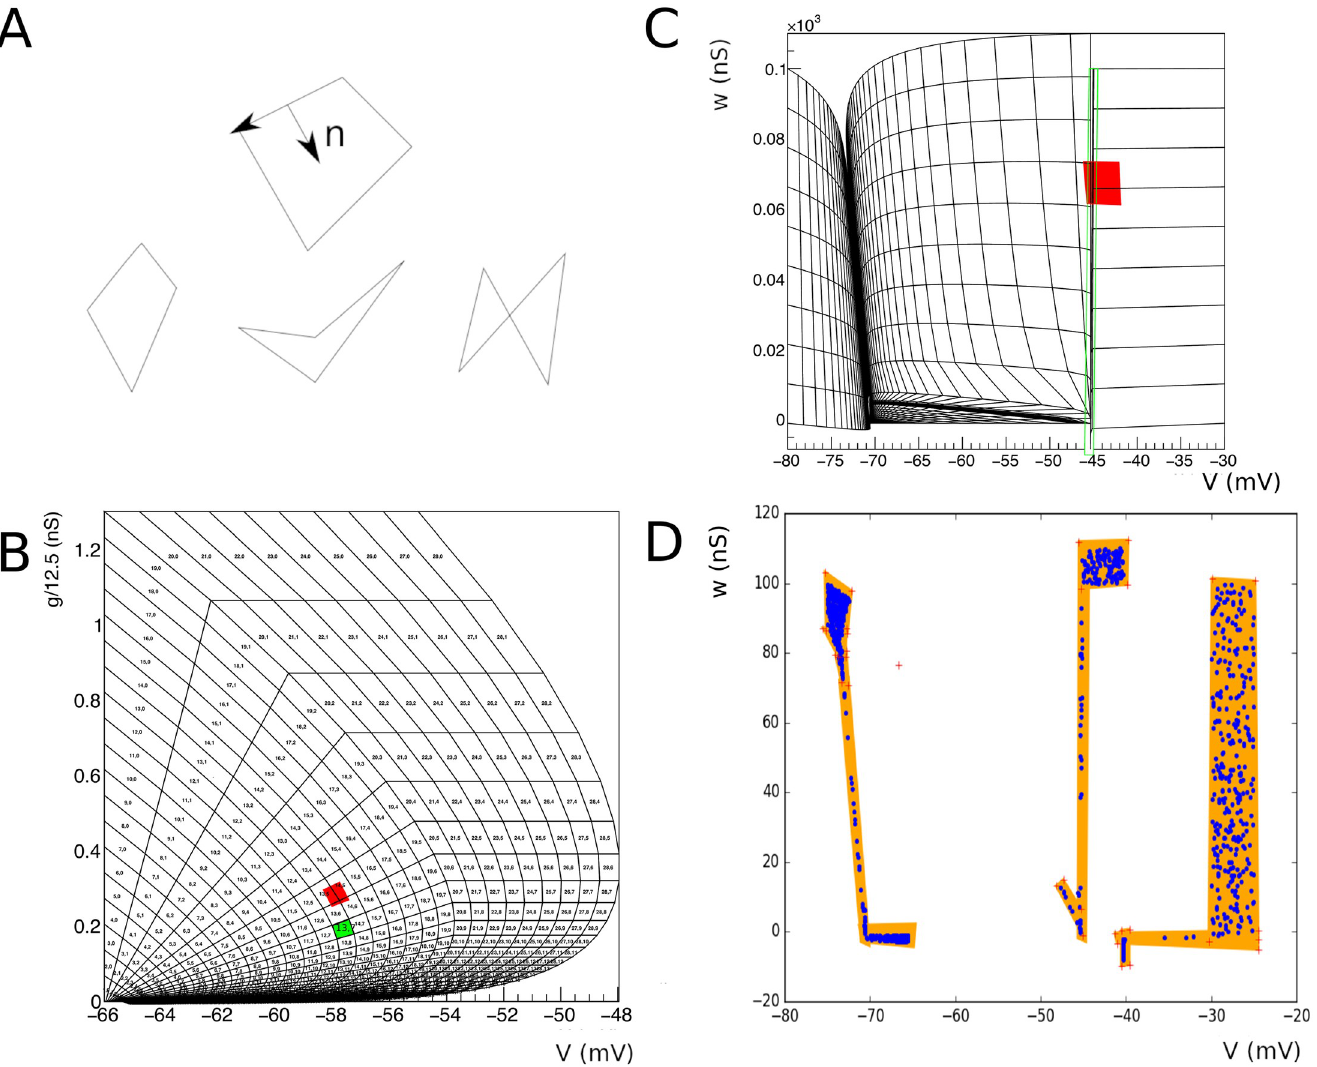
Fig 2. A: As a result of the integration procedure simple quadrilaterals (left, middle) should emerge, which are usually convex (left), except near stationary points or limit cycles where concave quadrilaterals (middle) can be formed. Complex, i.e. self-intersecting, quadrilaterals can occur around strong non linearities, for example the crossing of nullclines. These definitions hold for any polygon. B: The problem of defining the Master equation: we can easily calculate how much mass per unit time leaves a given bin ( i , j ). This mass will reappear at a position h away from the original bin, where h is the synaptic efficacy. In the figure bin (13,7) is translated along vector (0, 0.1). This corresponds to neurons that have received an input spike, and therefore are experiencing a jump in conductance. Most neurons that are in bin (13,7), will end up in bin (13, 5) and (14,4), with some in bin (13,6) and (14,6). So C (0.,0.1) (13, 7) = {(13, 5), (14, 5), (13, 6), (14, 6)}. C: Some events will end up outside of the grid after translation. D: Fiducial quadrilaterals can be used to test where they have gone missing, and where is the best place to reassign them to the